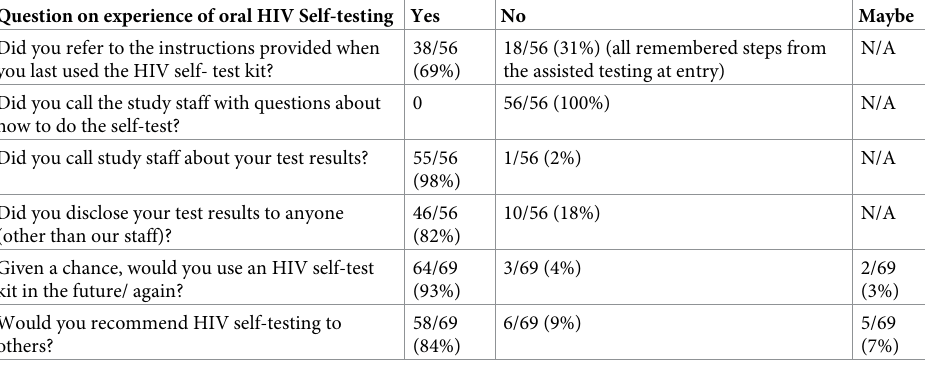
Table 2. Participants’ experience on oral HIV